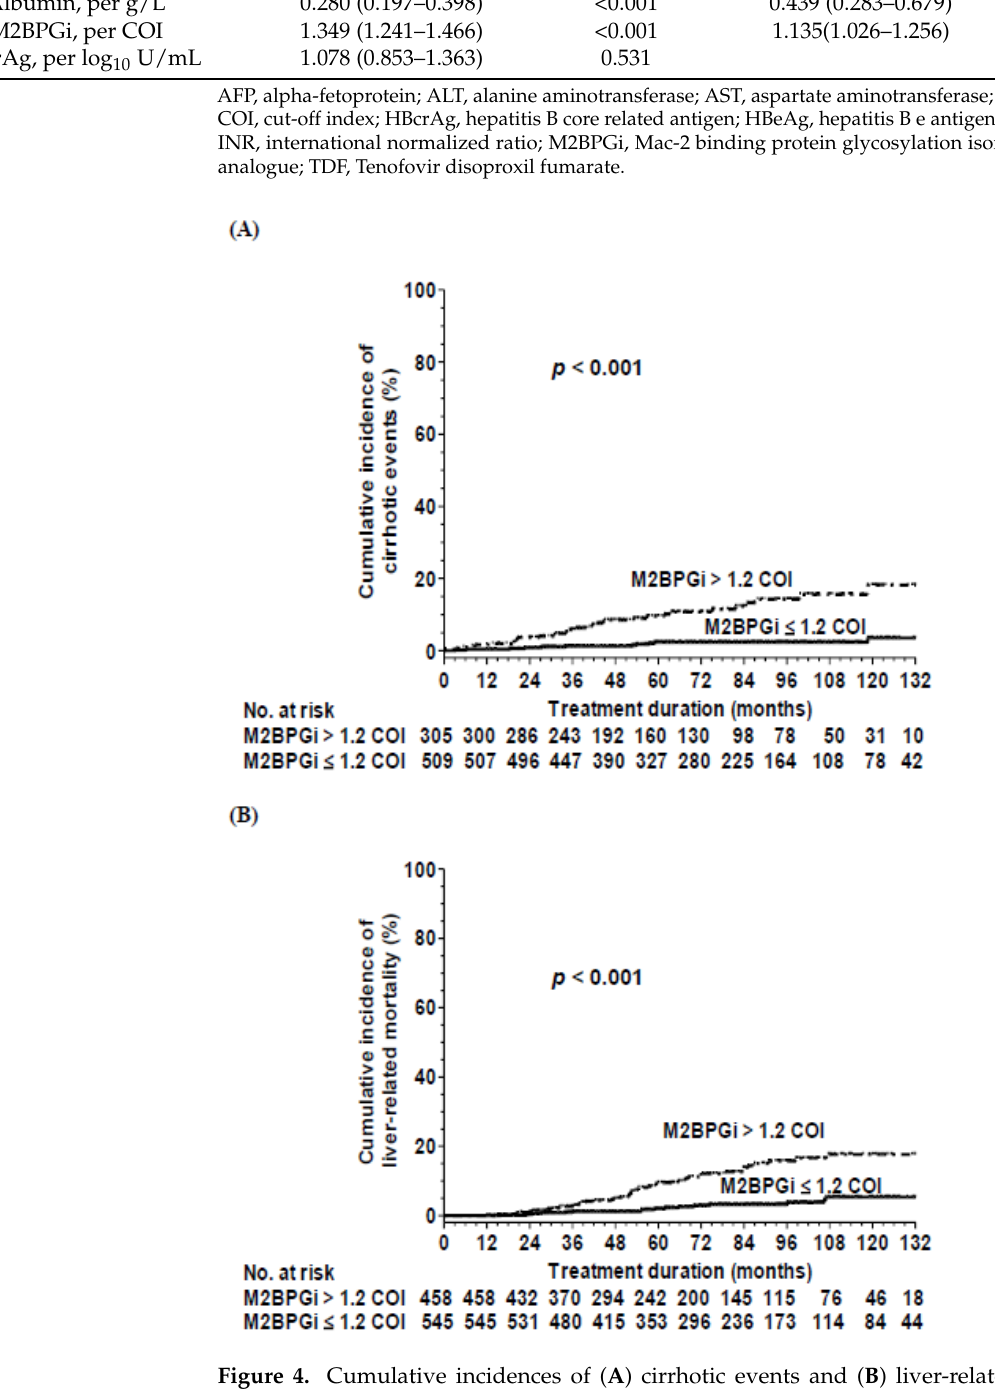
Figure 4. Cumulative incidences of ( A ) cirrhotic events and ( B ) liver-related morality or liver transplantation according to M2BPGi levels at 12 months of